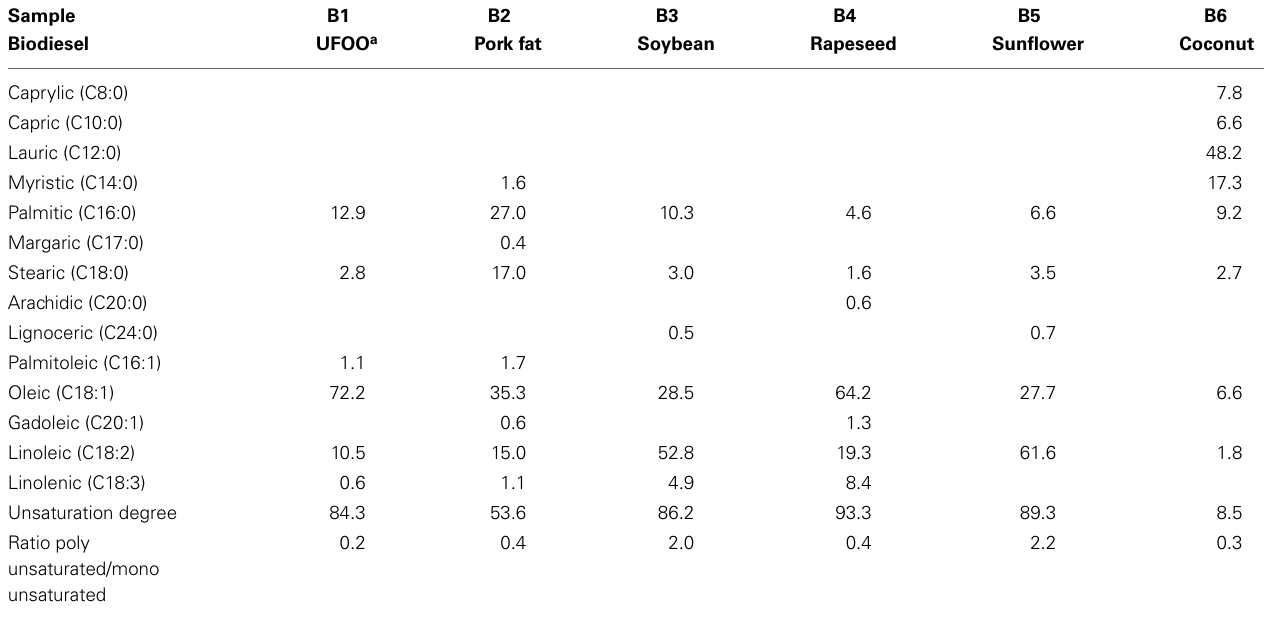
Table 1 | Quantitative analyses by GC/FID of the biodiesel produced from pure raw materials [% (m/m)].